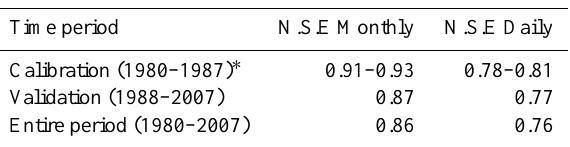
Fig. 7. Mean monthly discharge simulated (gray), observed (black dotted), simulated discharge from glacier melt (black), and glacier contribution (red) during the calibration period (1981–1986). The ranges of the simulated data encompass the predictions of five equally ranked optimal parameter sets, indicating uncertainty from parameter selection. Table 2. Monthly and daily Nash–Sutcliffe efficiency values for simulated streamflow.